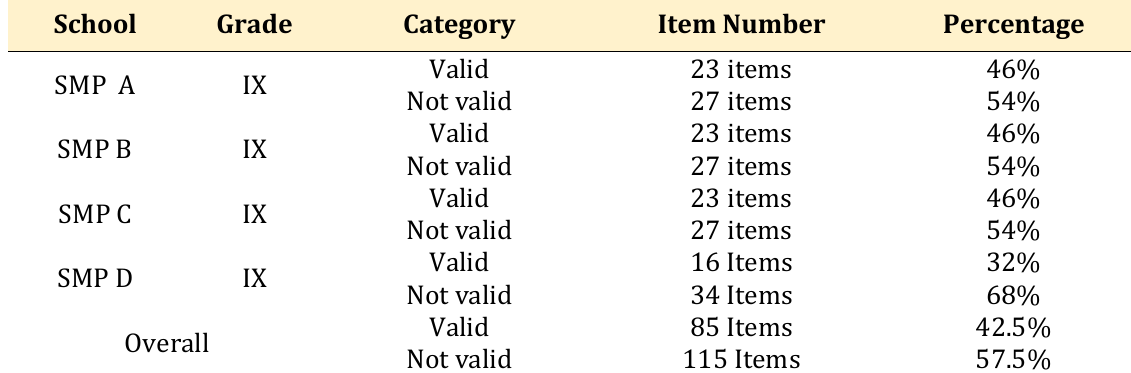
Table 1. Validity of the Tests